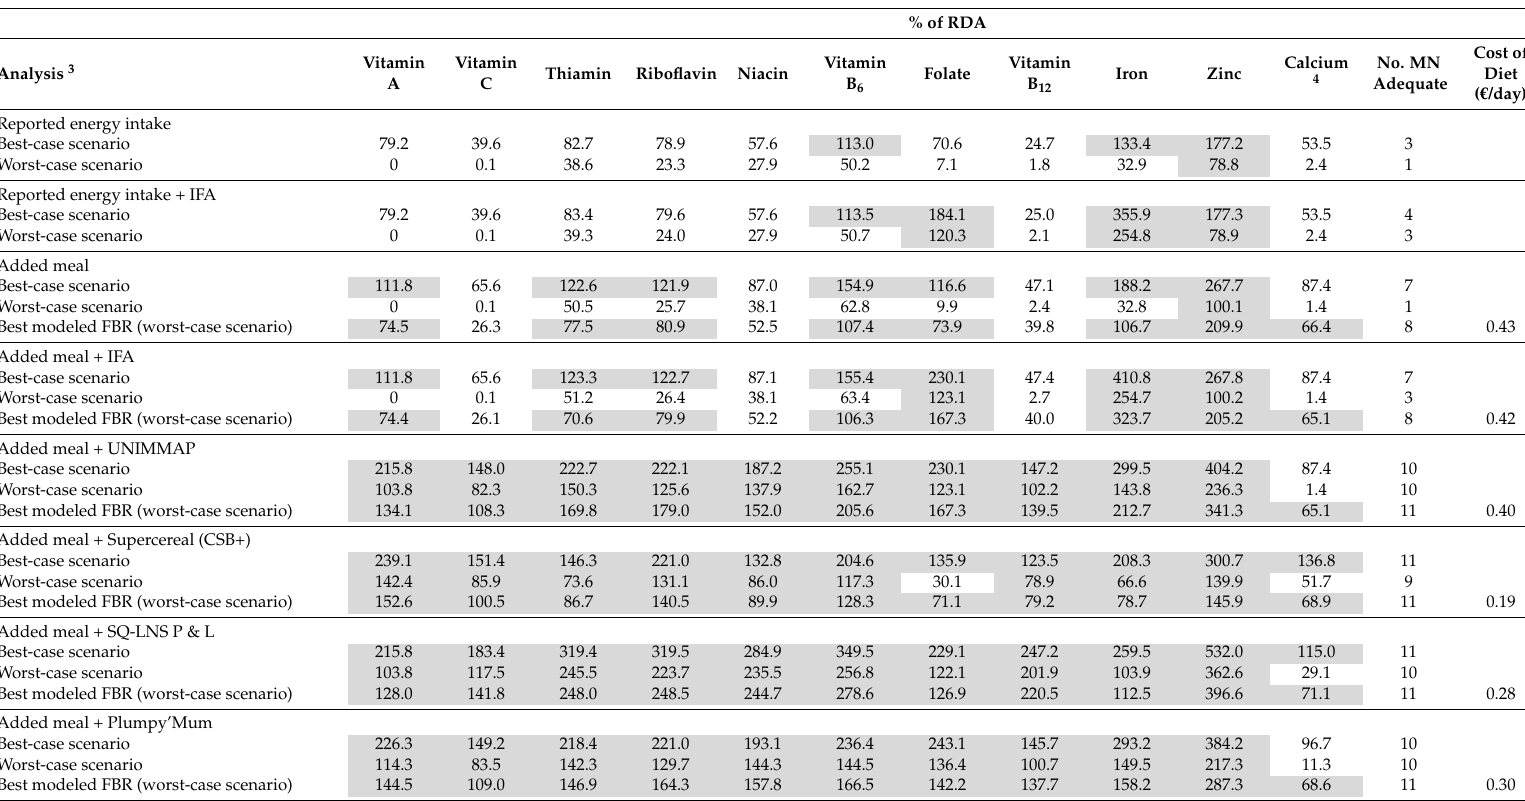
Table 4. The nutrient content of worst-case and best-case scenario diets without food-based recommendations (module III), and food-based recommendations with the greatest nutritional impact expressed as a percentage of Recommended Dietary Allowances (RDA) among pregnant women 1,2